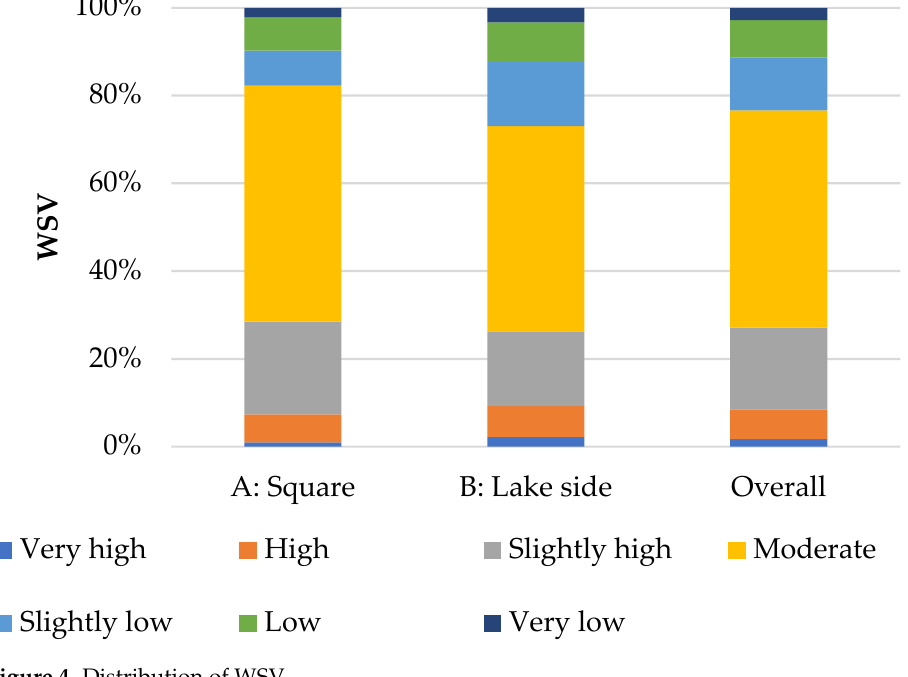
Figure 4. Distribution of WSV.